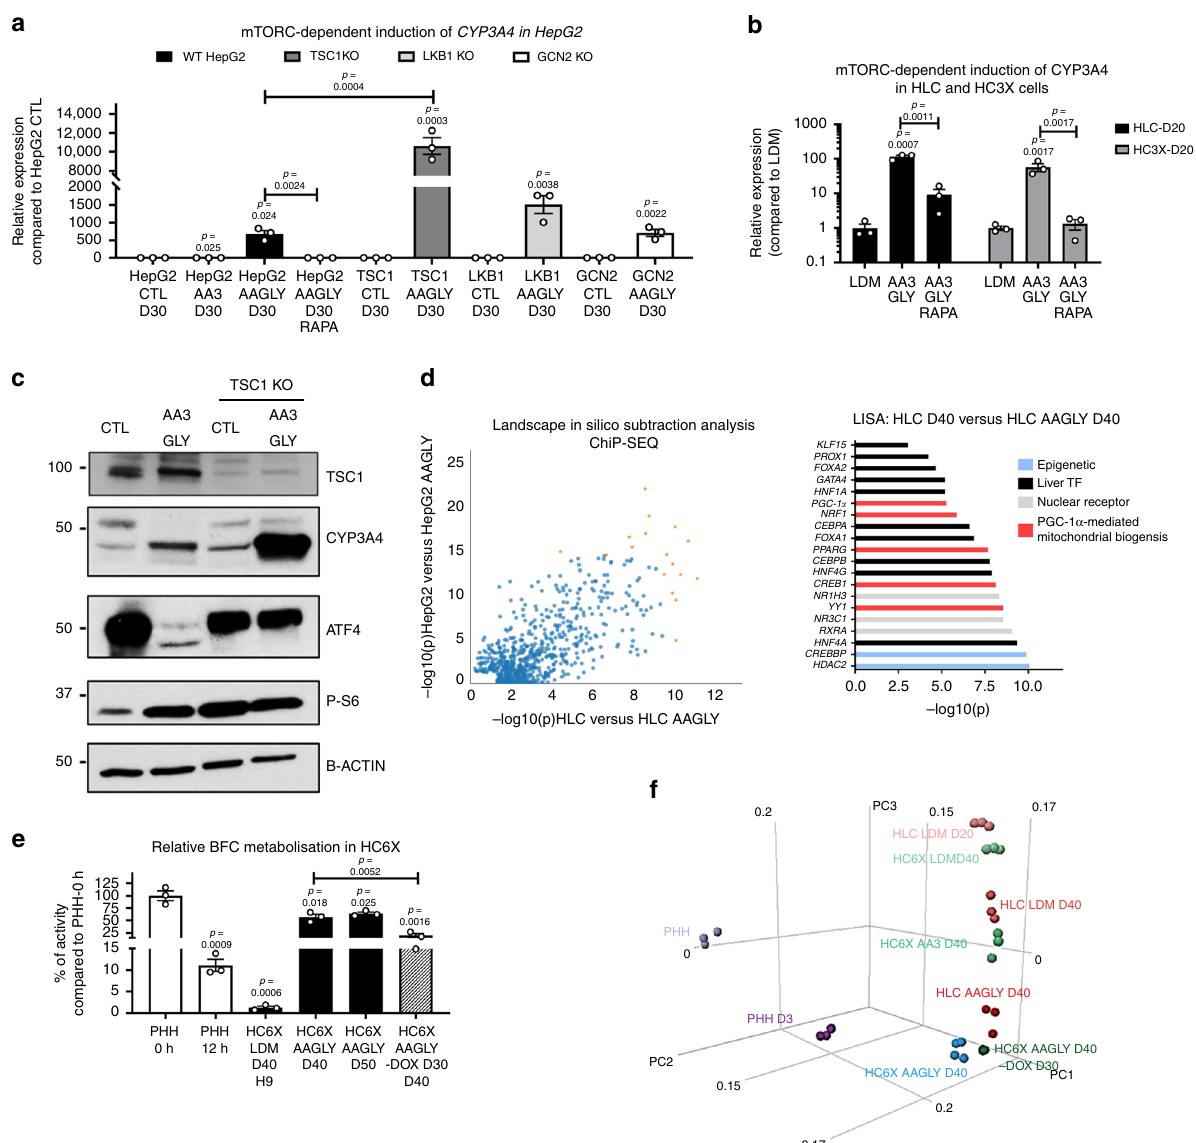
Fig. 6 AAGLY-mediated maturation is dependent on activation of mTORC1. a Relative expression of CYP3A4 in HepG2 differentiated with AAGLY, in combination with rapamycin addition (RAPA), or using HepG2 wherein TSC1 , GCN2 , or LKB1 were knocked out. N = 3 independent differentiations. Signi fi cance was calculated by comparing against HepG2 CTL. Signi fi cance was also calculated between Hepg2 AAGLY D30 and HepG2 AAGLY RAPA, and between HepG2 AAGLY D30 and TSC1 KO AAGLY D30 when indicated. Signi fi cance was calculated by unpaired two-tailed Student ’ s t -test. b Relative gene expression analysis for CYP3A4 in HLC and HC3X differentiated with AAGLY until D20, with or without rapamycin (RAPA). Expression of HLCs and HC3X cells was related to differentiations in LDM. N = 3 independent differentiations. Signi fi cance was calculated by comparing against the LDM and between LDM AA3GLY and LDM AA3GLY RAPA by two-tailed unpaired Student ’ s t -test. c Western blotting analysis comparing the phosphorylation of S6 and the expression of ATF4 and CYP3A4 in HepG2 differentiated in control media or AAGLY media, with or without KO of TSC1 . Representative blot of two repeats. d LISA analysis identifying the top TFs responsible for the genome wide difference between HepG2 and HLC grown in control or AAGLY media. e BFC metabolization comparing HC6X LDM D40 and HC6X AAGLY D40/50, as well as HC6X AAGLY D40 where doxycycline was removed from d30 onwards (HC6X AAGLY D40-DOX from D30). N = 3 independent differentiations. N = 3 donors for PHHs. Signi fi cance was calculated as compared with PHH 0 h by unpaired two-tailed Student ’ s t -test. Signi fi cance was also calculated between HC6X AAGLY D40 and HC6X AAGLY – DOX D30-D40. f PCA plot showing the distribution of HLCs, HC3X, and HC6X differentiated in different media and compared with PHHs. Data in all panels represent mean ± SEM with P -values indicated when signi fi cant. Source data are provided as a Source Data fi